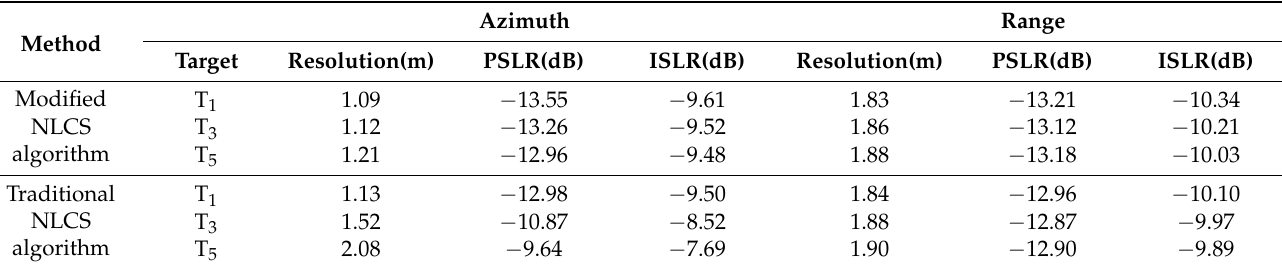
Table 2. The imaging performance index of different